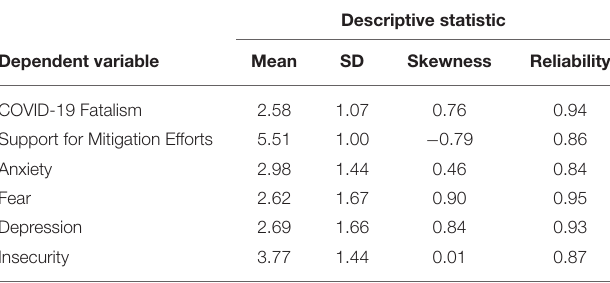
TABLE 2 | Descriptive statistics for dependent variables.